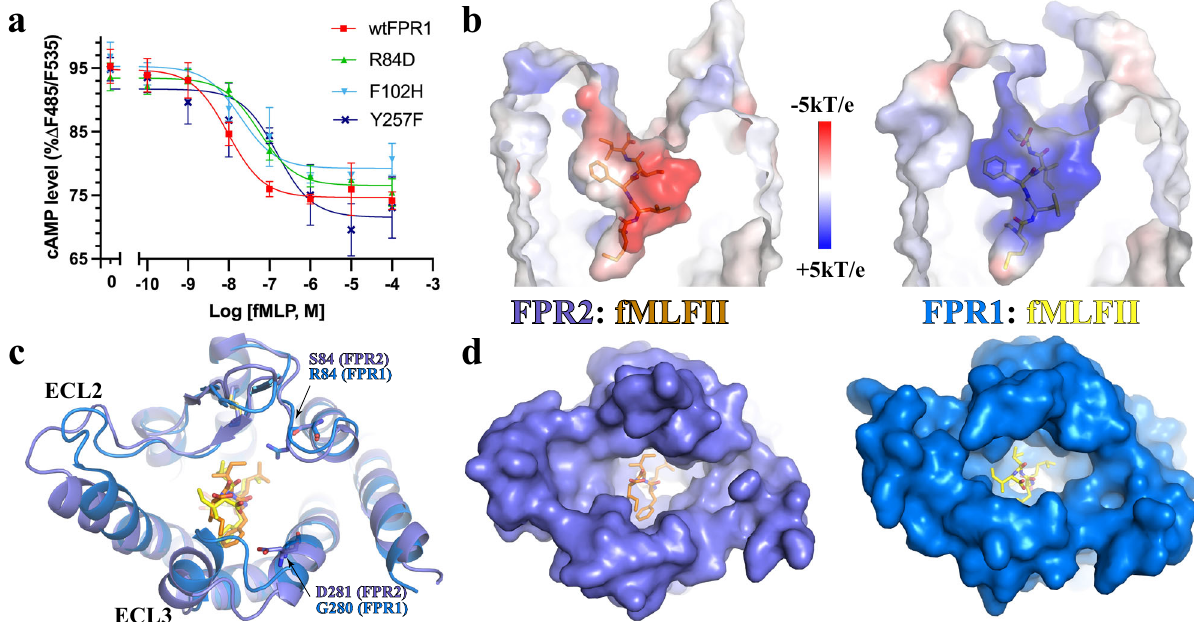
Fig. 4 Structural differences between FPR1 and FPR2. a Dose-dependent action of fMLFII on wide type FPR1 (wtFPR1) and FPR1 with mutations of three non-conserved residues to their counterparts in FPR2. Agonist-induced FPR1 signaling was measured by cAMP accumulation assay. Each data point represents mean ± S.D. Three independent assays were performed. Source data are provided as a Source Data fi le. b Charge distributions of fMLFII-binding pockets in FPR1 and FPR2. Overall binding modes of fMLFII in FPR1 (blue) and FPR2 (slate). c Alignment of the extracellular regions of FPR1 and FPR2 showing different conformations of ECL2 and ECL3. Two non-conserved residues, S84 and D283 in FPR2 (slate) and R84 and G280 in FPR1 (blue), are shown as sticks. d Structural comparison of the extracellular surfaces of FPR1 and FPR2. fMLFII is colored orange in FPR2 and yellow in FPR1. ECL extracellular